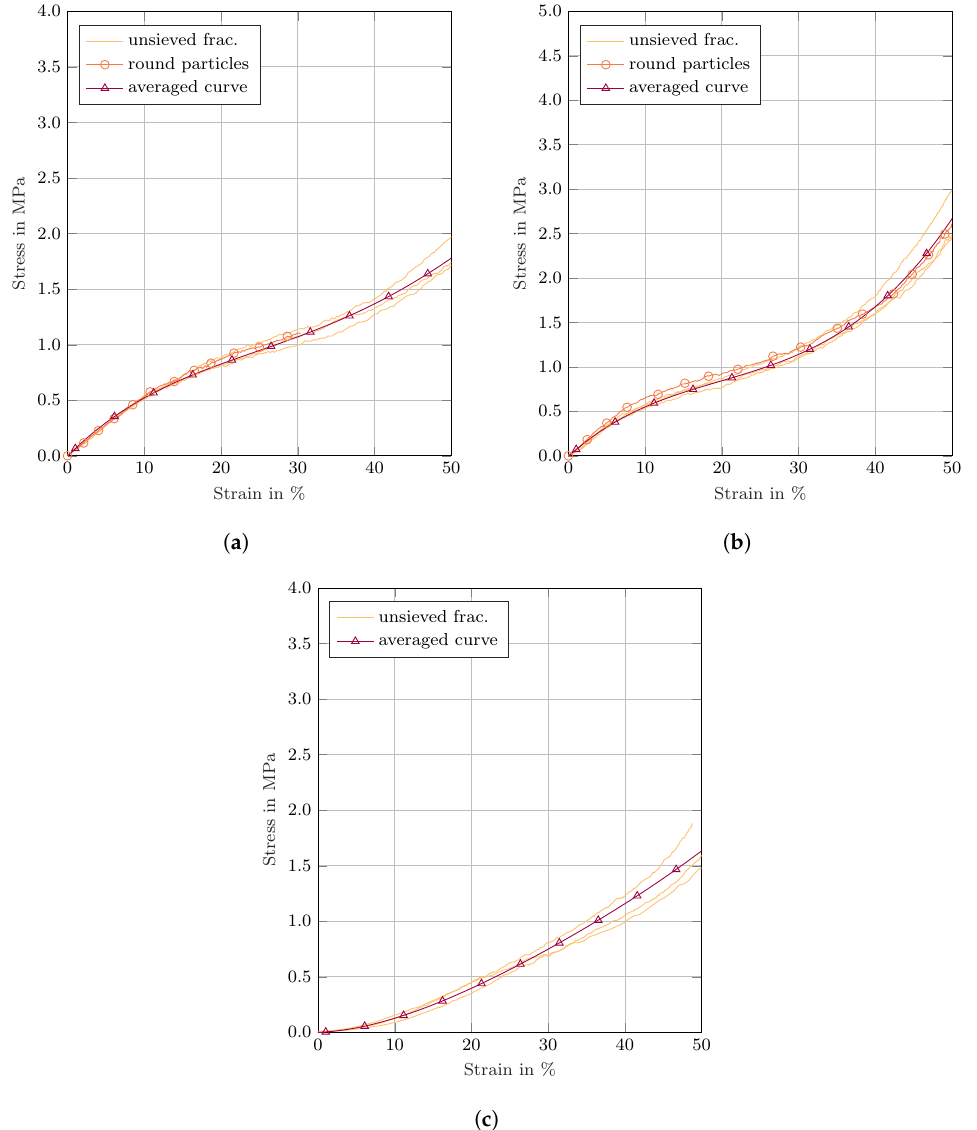
Figure 10. Stress–strain curves for multi-particle compression test of unsieved uncoated, Candelilla wax-coated and silicone-coated Poraver ® particles. ( a ) Poraver ® —Pure. ( b ) Poraver ® —Candelilla wax. ( c ) Poraver ®